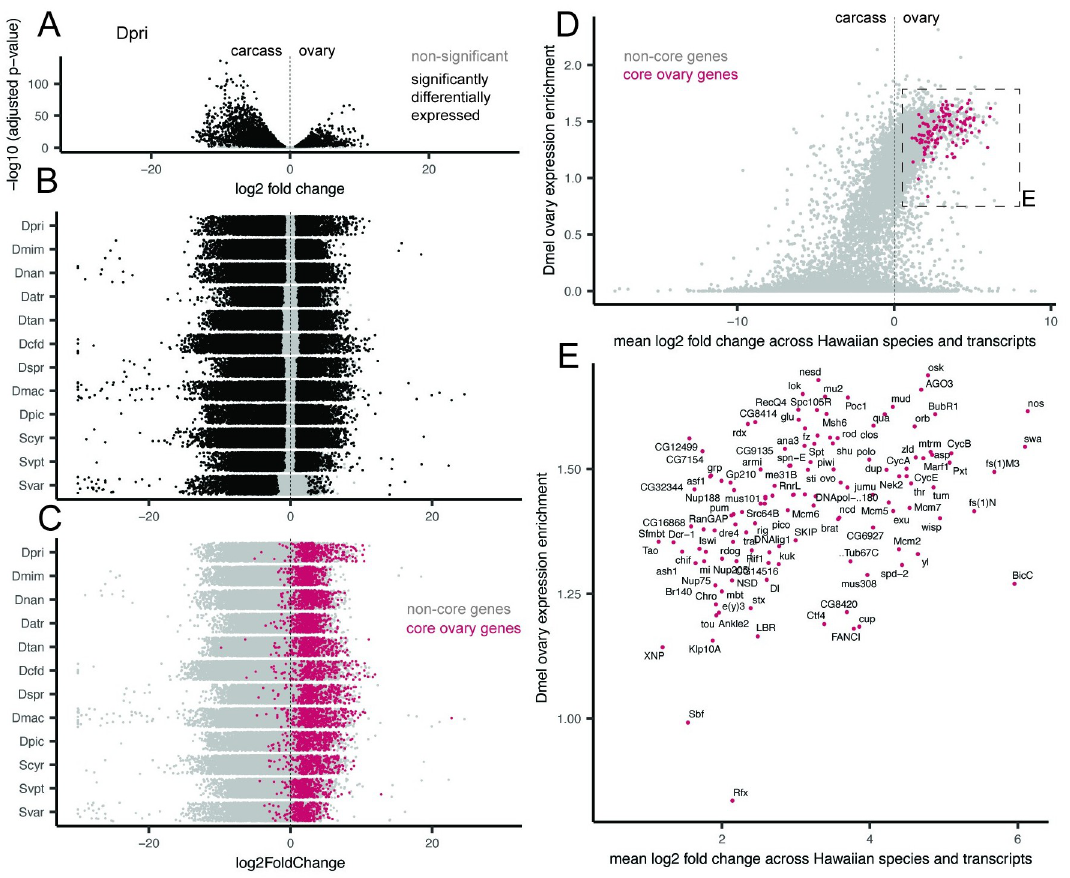
Fig 2. Identifying a cohort of ovary-specific genes across drosophilid species. A, Volcano plot for one example species, D. primaeva (Dpri), showing the results of a differential gene expression analysis comparing the ovary to the carcass. The x-axis shows the log 2 fold change of expression across transcripts, and the y-axis shows the adjusted p-value, log 10 transformed. Points that are significantly differentially expressed are shown in black. B, Jitter plots showing the results of the same analysis across the twelve species studied here. The x-axis shows the log 2 fold change of expression across transcripts, and points are arranged with random jitter within species on the y-axis. C, The same jitter plots as in B, now colored according to whether or not transcripts belong to a cohort of core ovary genes. These are defined as genes, grouped by BLAST similarity to D. melanogaster transcripts, for which at least one transcript is upregulated in the ovary of ten or more of the twelve species. D, A comparison of mean expression change across Hawaiian species to reported ovary-enrichment values from D. melanogaster , as reported in FlyAtlas2 [29]. Core ovary genes are marked in magenta. E, The boxed region shown in D, magnified and now showing only core ovary genes, annotated with the gene symbol from D. melanogaster